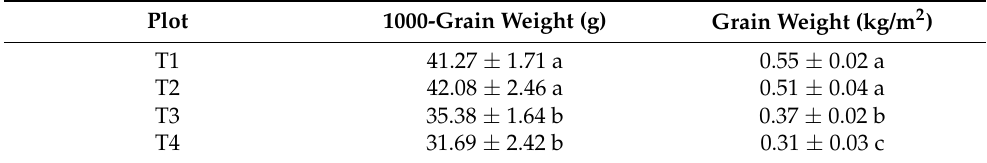
Table 3. Irrigation times and irrigation amounts of experimental plots under different water stresses. Each value indicates the mean ± standard deviation (SD). In a column, values with dif- ferent letters indicate significant differences at p < 0.05.